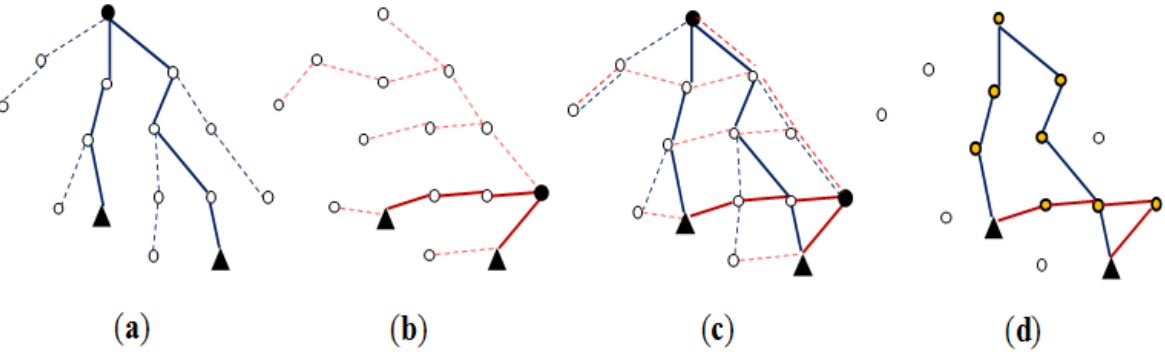
and n is in use to make the join path 1 2